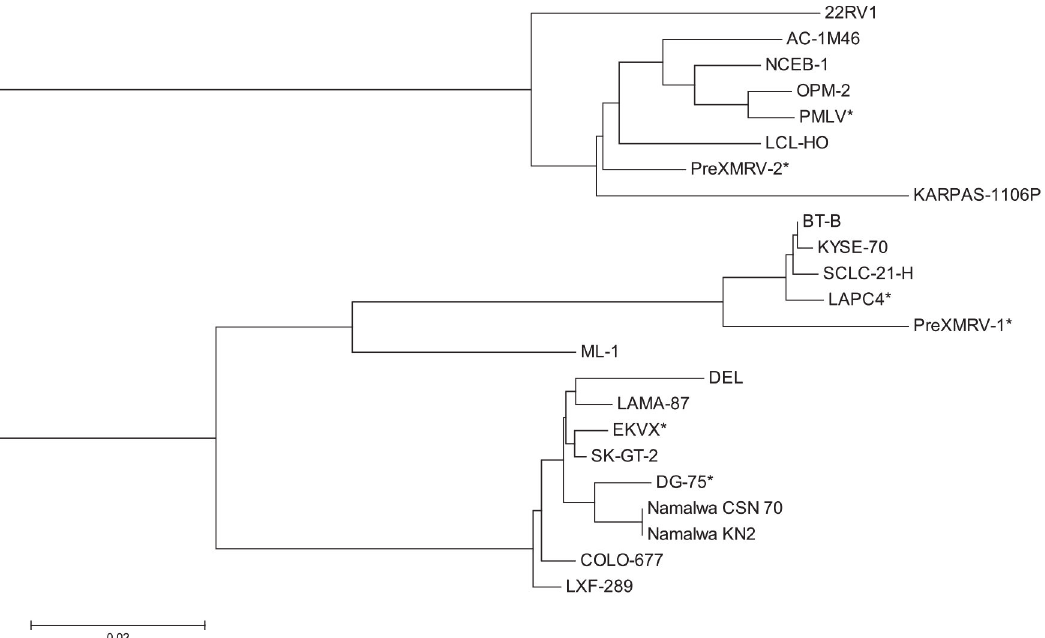
Fig 4. Neighbor joining tree of the MLV sequences of the first round PCR products. The chart demonstrates the relationship of the MLV sequences generated with the outer primer pair of the detection PCR reaction. The alignment and the tree construction were performed with the MEGA6 software. Three major groups of MLV subtypes can be identified. The scale bar represents the number of nucleotide substitutions per site. * Sequences obtained from the NCBI sequence